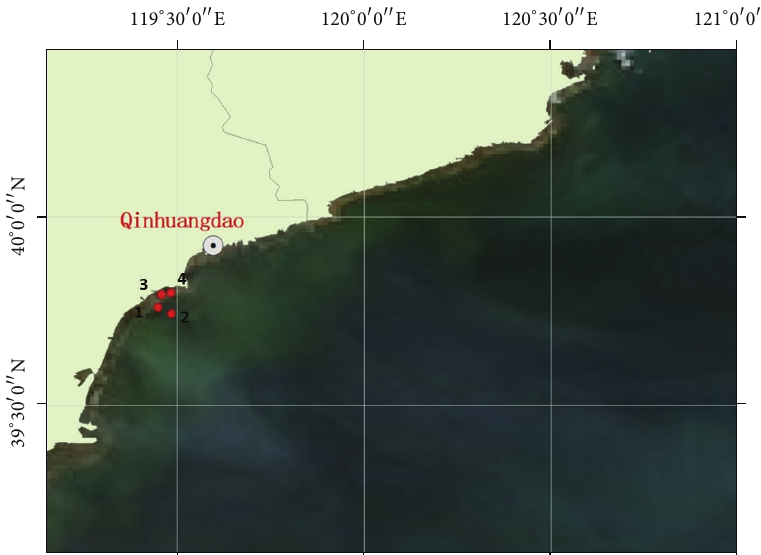
Figure 2: The MODIS data of study region and the stations (solid circles) in the Bohai Sea around Qinhuangdao of China.